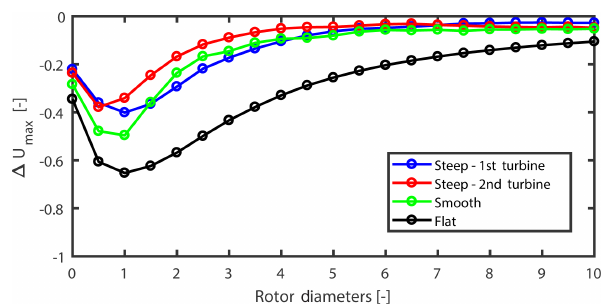
Figure 12. Maximum normalized mean velocity deficit as a func- tion of downstream distance for different